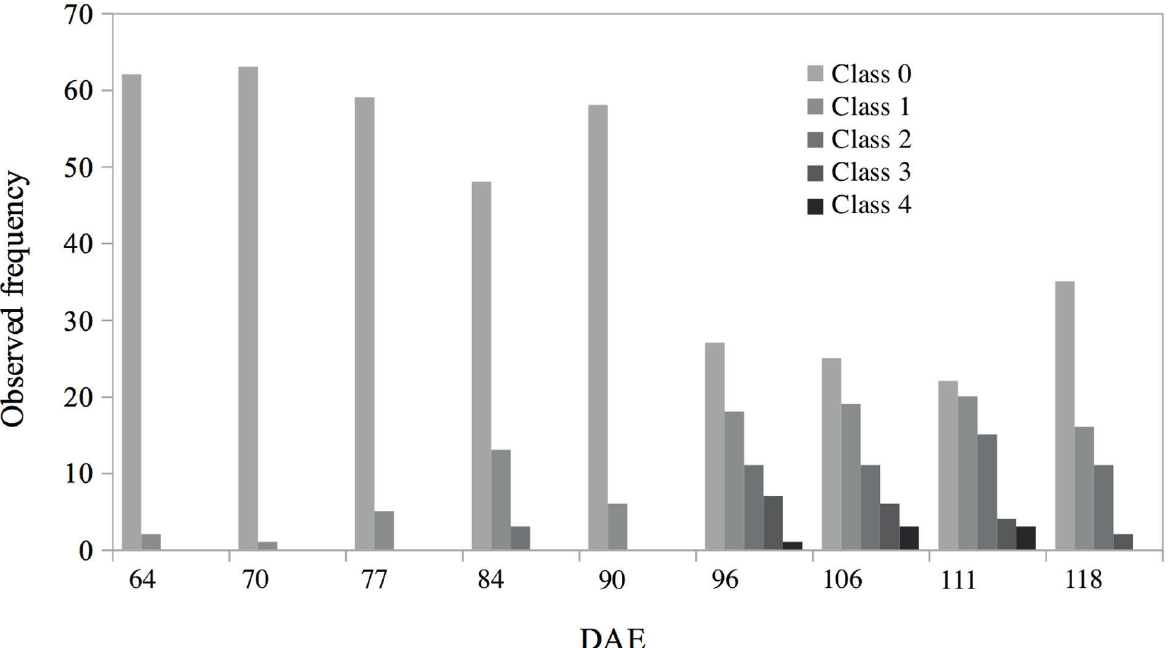
Figure 1 - Observed frequency of E. heros in nine cotton sampling dates between 64 and 118 days after emergence (DAE), and grayscale color representing each class. Dourados - MS,